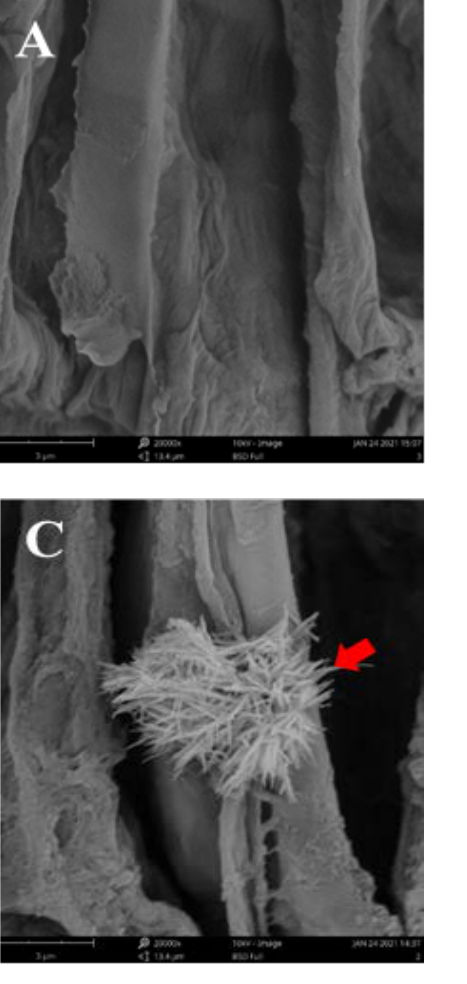
Figure 6. Colonization of S. sphenanthera roots by bacteria and fungi in different treatment groups. ( A ) Roots of S. sphenanthera in control group, in which no microbes were found. ( B ) Roots of S. sphenanthera in AB, in which red arrow represents colonized bacteria. ( C ) Roots of S. sphenanthera in AF, in which red arrow represents colonized fungi. ( D ) Roots of S. sphenanthera in ABF group, in which red arrow represents coexistence of colonized bacteria and fungi.